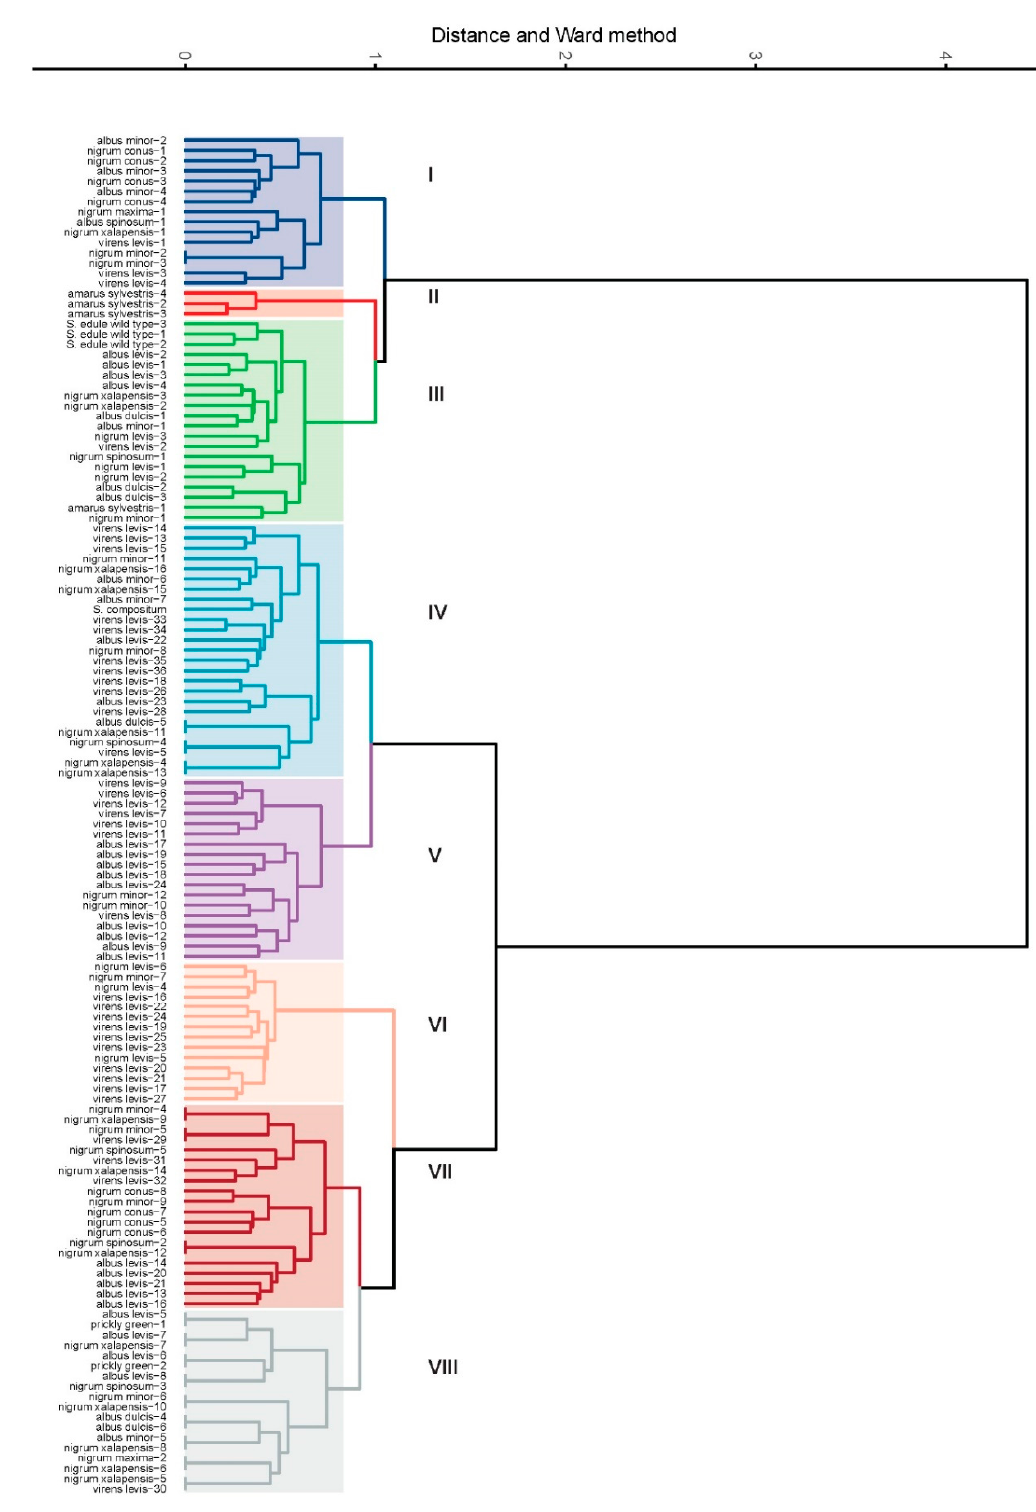
Figure 4. Dendrogram of accessions of S. edule using AFLP molecular markers, constructed using Dice coefficients and the simple hierarchical grouping method UPGMA. Roman numerals indicate the colored groups at a genetic distance of 0.215. Dendrogram of S. edule accessions using AFLP molecular markers, constructed using Dice coefficients and the UPGMA simple hierarchical clustering method. Roman numerals I–VIII indicate the groups at a genetic distance of